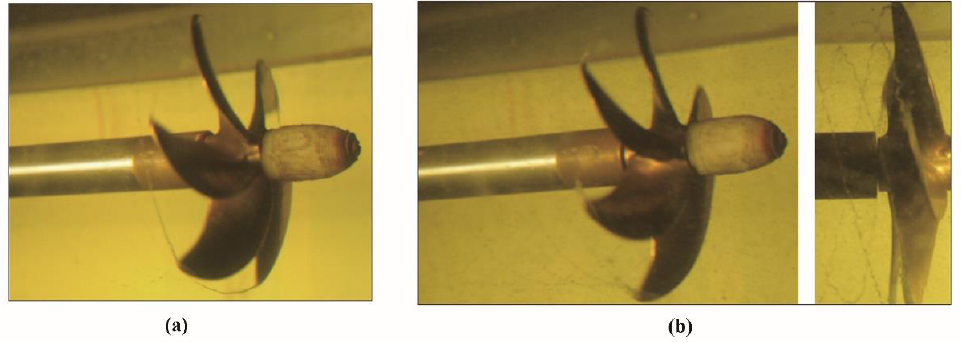
Figure 7. Cavitation inception and development in the propeller: ( a ) 80 kPa and ( b ) 70 kPa.